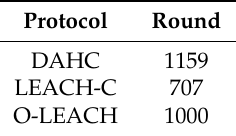
Table 4. The round of the FND (first node dies) when the BS is inside. Table 5. The round of the FND when the BS (base station) is outside.